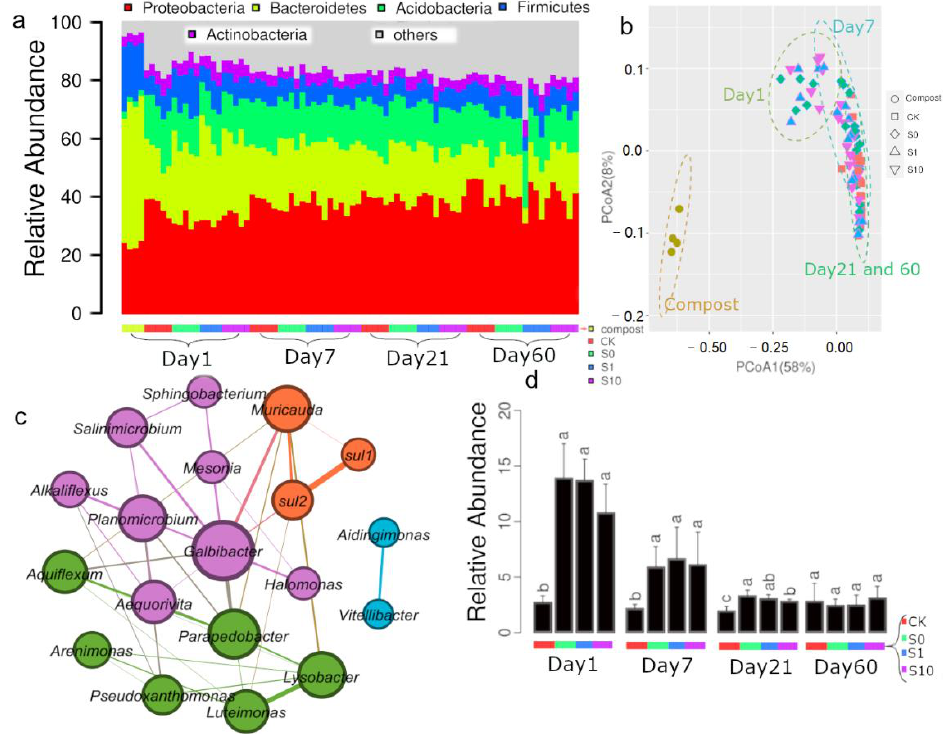
Figure 3. The relative abundance of dominant compost bacteria ( a ), PCoA (principal coordinate analysis) of bacterial community ( b ), the co-occurrence network between sul1 , sul2 and bacterial taxa ( c ) and the relative abundance of the three interlinked hubs in different treatments ( d ). CK: soil; S0: soil amended with compost; S1: soil amended with compost and 1 mg kg −1 of sulfadiazine; S10: soil amended with compost and 10 mg kg −1 of sulfadiazine.